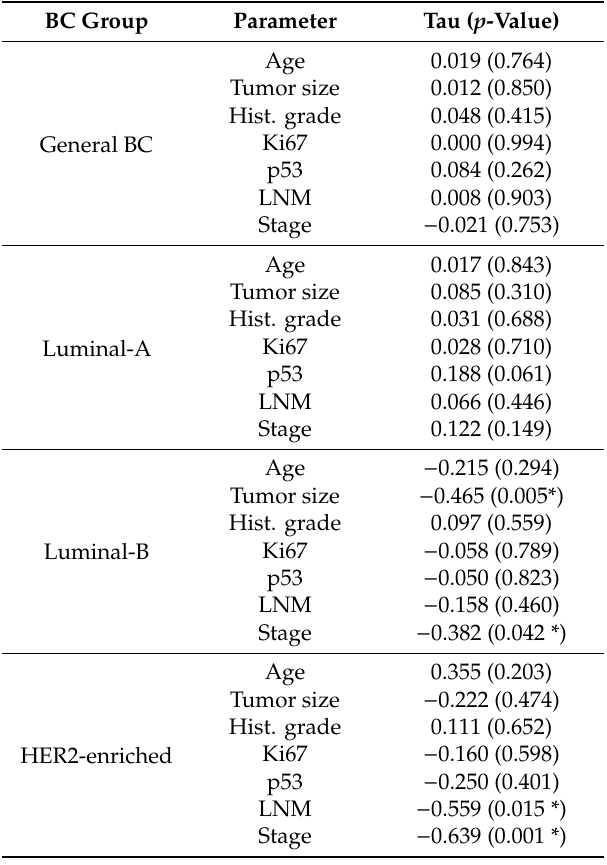
Table 3. Correlation analyses between MMTV- env in tumor tissue and clinicopathological parameters.